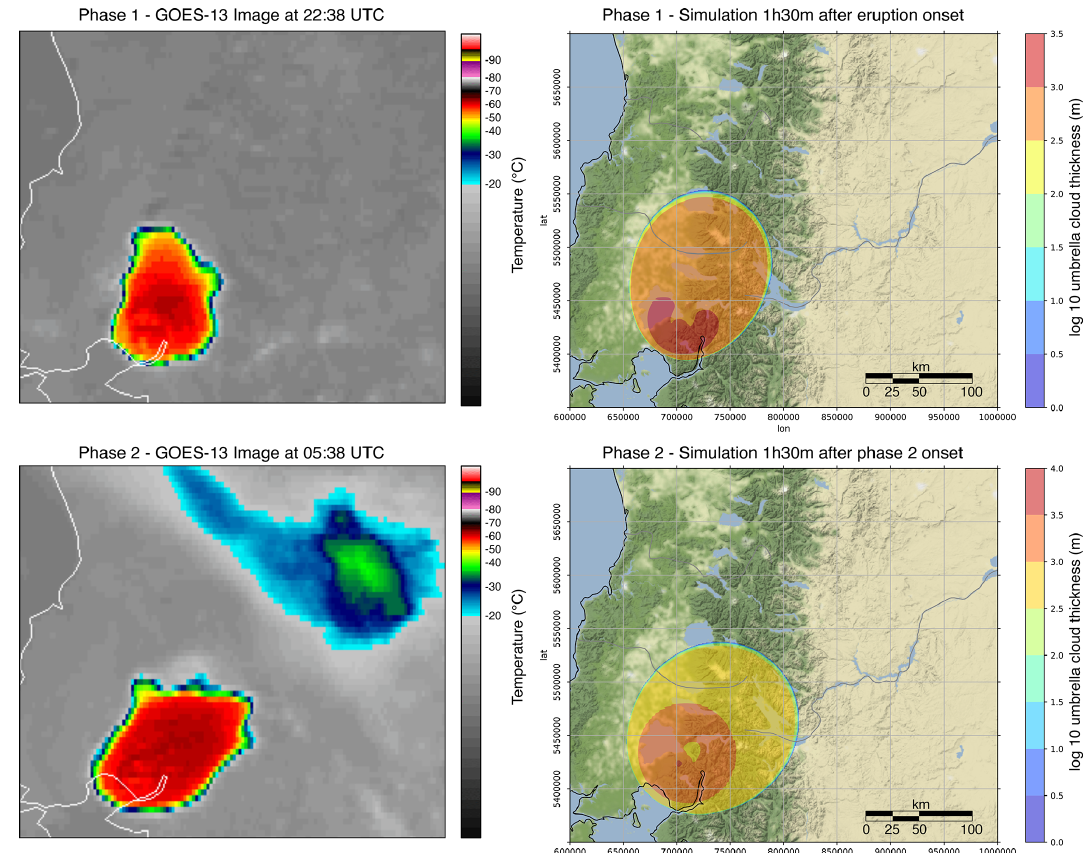
Figure 8. Left panels show the cloud-top IR brightness temperature as retrieved by the NOAA GOES-13 geostationary satellite, channel 4 (images from http://rammb.cira.colostate.edu, last access: 14 February 2021). Right panels show simulated umbrella cloud thickness contours 1.5h after the onset of phase 1 (top) and phase 2 (bottom), obtained with C D = 0 . 1. Please note that in the right panels the color scales for the two phases are